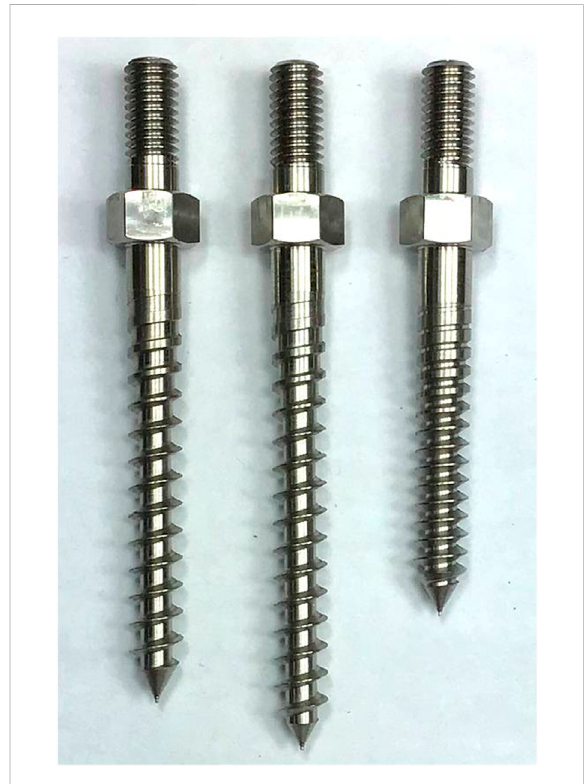
FIGURE 1 Photograph showing three types of pedicle screws used in TT, MT, and CBT trajectories (from left to right). The dimensions (diameter × length) of the TT, MT and CBT screws were 6.0 mm × 45 mm, 6.0 mm × 50 mm and 6.0 mm × 35 mm, respectively. The screw pitches of the TT, MT and CBT screws were 3.0 mm, 3.0 mm and 1.5 mm, respectively. All screws had identical thread depths of 1.2